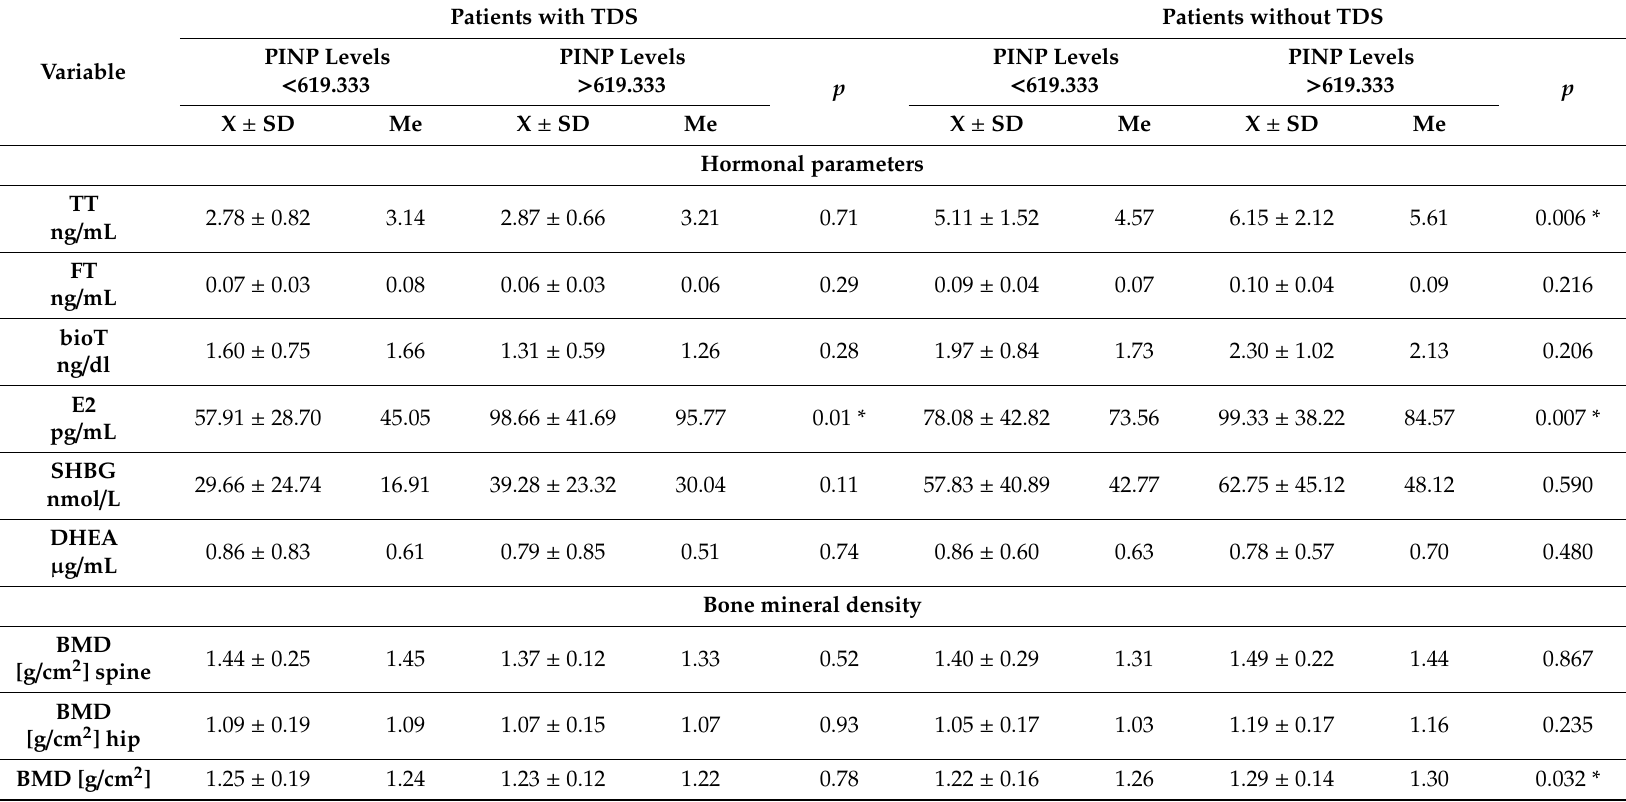
Table 3. Comparison of the groups of patients with and without TDS divided with regard to PINP levels > 619.333. Patients with TDS Patients without TDS PINP Levels PINP Levels Variable < 619.333 > 619.333 p